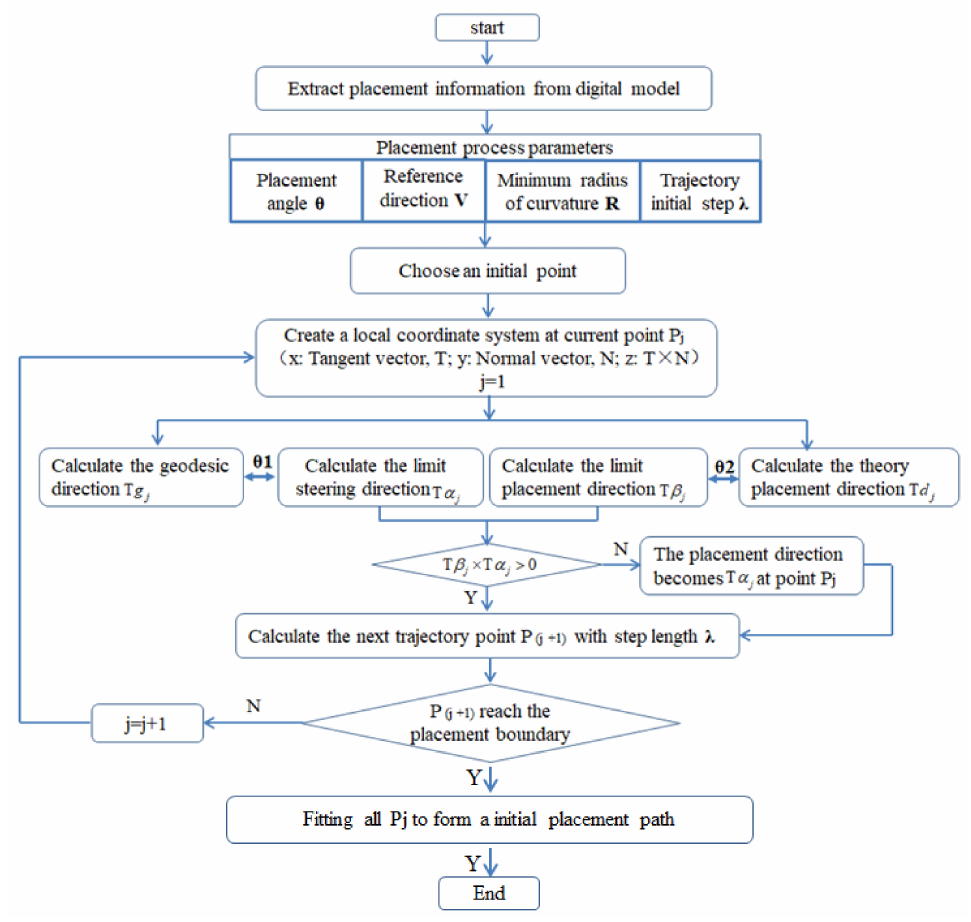
Figure 4. Flow chart of the path generation method.